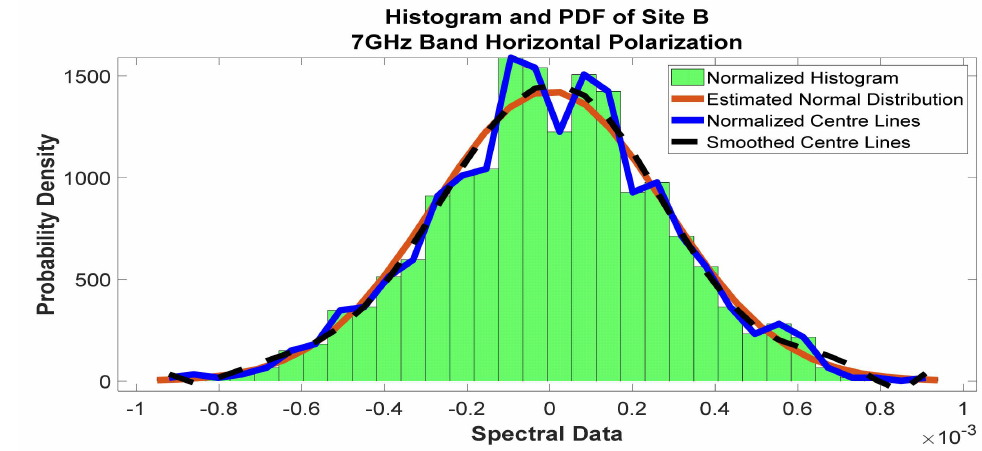
Figure 20. Histogram and PDF of the frequency scan for site B at 7 GHz horizontal polarization.